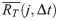
Measuring average elongation rate by applying Eq (7) to in silico and in vivo ribosome run-off data.(A) Normalized average ribosome read density (RT-(j,Δt)), Eq. (S15), calculated from simulated ribosome run-off experiment is plotted as a function of codon position for run-off times of 0, 5, 10, 15, 20, 25 and 30 s−1 with black, red, blue, cyan, pink, yellow and green data points, respectively. (B) The average time taken to fully deplete the normalized average ribosome read density within a window of the most 5′ codons positions in S. cerevisiae transcripts are plotted against the most 3′ codon position of the window. (C) Normalized average ribosome read density, calculated from in vivo run-off experimental data reported in Ref. [26], are plotted as a function of codon position for the run-off times of 0, 90, 120 and 150 seconds with black, red, blue and cyan data points, respectively. (D) The average time taken to fully deplete the normalized average ribosome read density within a window of the most 5′ codons positions in mouse stem cells transcripts are plotted against the most 3′ codon position of the window. The negative intercept reflects the time taken by harringtonine to engage with ribosomes.